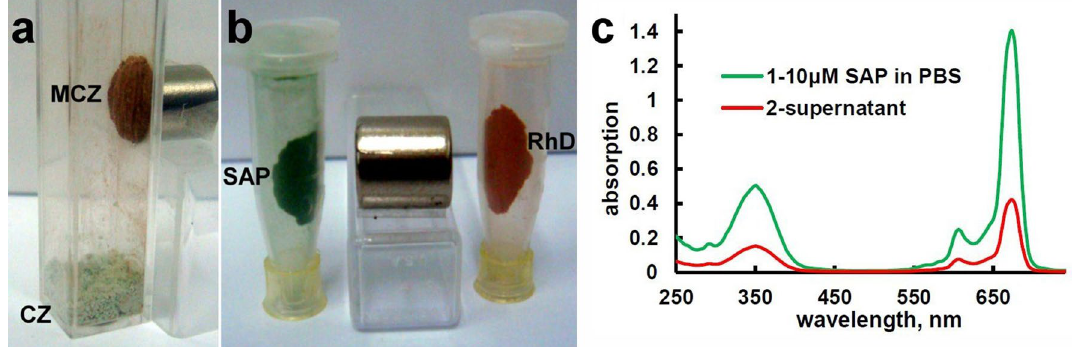
Figure 2. Magnetic separation of pure MCZ particles and MCZ with adsorbed dyes. ( a ) Magnetic separation of MCZ particles from natural CZ powder by a permanent magnet; ( b ) magnetic agglomeration of SAP-MCZ (green) and RhB-MCZ (red) particles near the magnet. ( c ) Absorbance spectra of 5 mM SAP and supernatant of SAP-MCZ complex revealed ~ 70% adsorption of SAP by MCZ in PBS buffer solution.